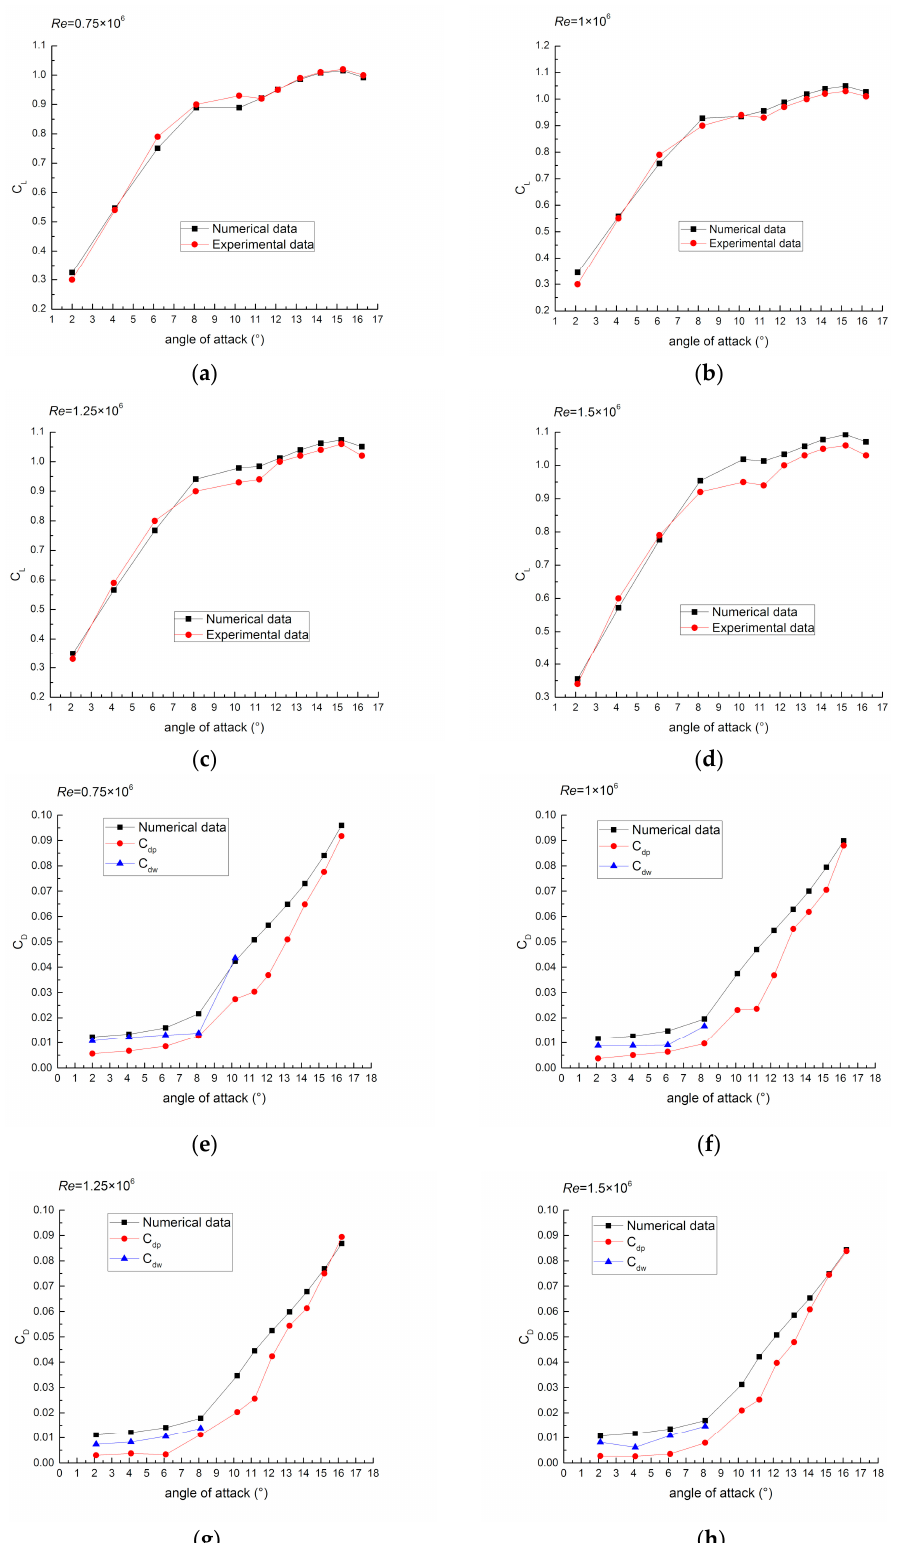
Figure 3. Lift and drag coefficient comparisons for S809 airfoil in one-phase air flow: ( a ) C L at Re = 0.75 × 10 6 ; ( b ) C L at Re = 1 × 10 6 ; ( c ) C L at Re = 1.25 × 10 6 ; ( d ) C L at Re = 1.5 × 10 6 ; ( e ) C D at Re = 0.75 × 10 6 ; ( f ) C D at Re = 1 × 10 6 ; ( g ) C D at Re = 1.25 × 10 6 ; ( h ) C D at Re = 1.5 × 10 6 .